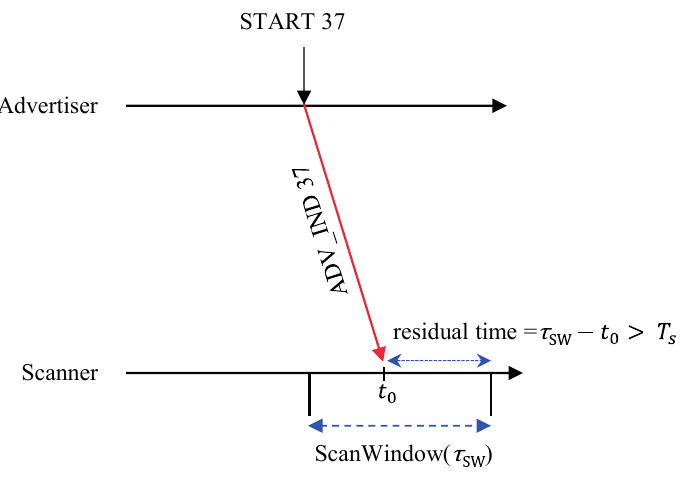
Figure 4. Case (E1 ∩ E4) for successful discovery in 1:1